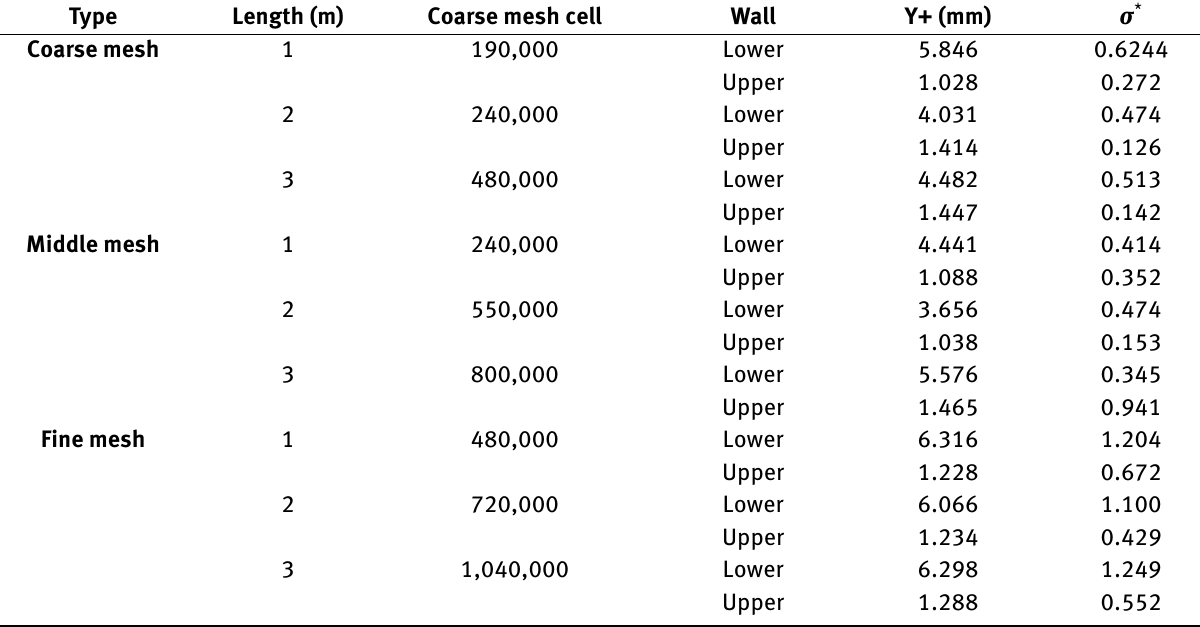
Table 3: Estimation of y + and standard deviation for mesh types and channel lengths Type Coarse